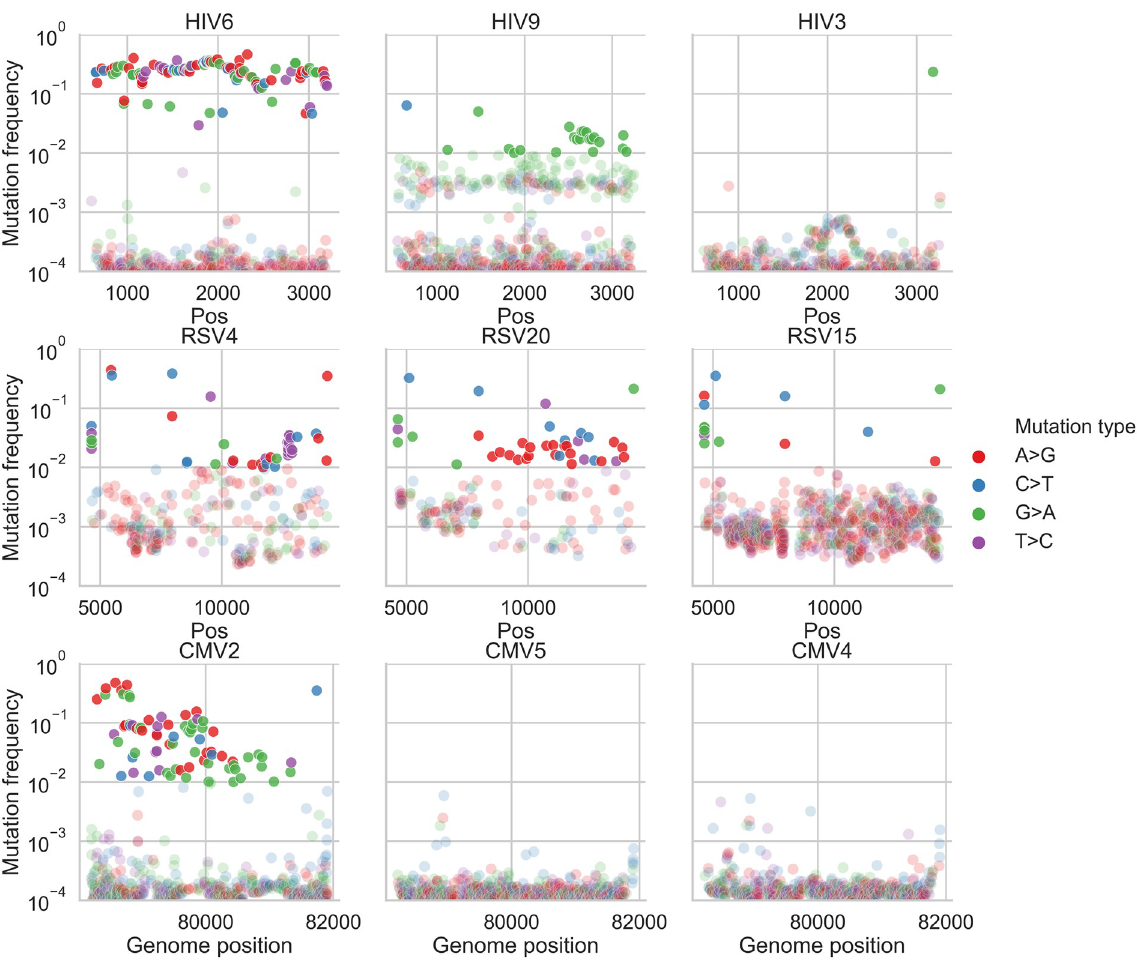
Fig 2. Variant frequency plots in representative samples. Shown are frequencies of transition variants called by AccuNGS, for representative samples from each virus (HIV, top row, RSV, middle row, CMV, bottom row). Variant frequencies lower than 1% are faded. Samples exemplify mixed genotype infections (HIV6, CMV2), mutation biases and presumable hypermutation via host editing (HIV9, RSV samples), and relatively homogenous populations (HIV3, CMV5, CMV4) (see text for details).